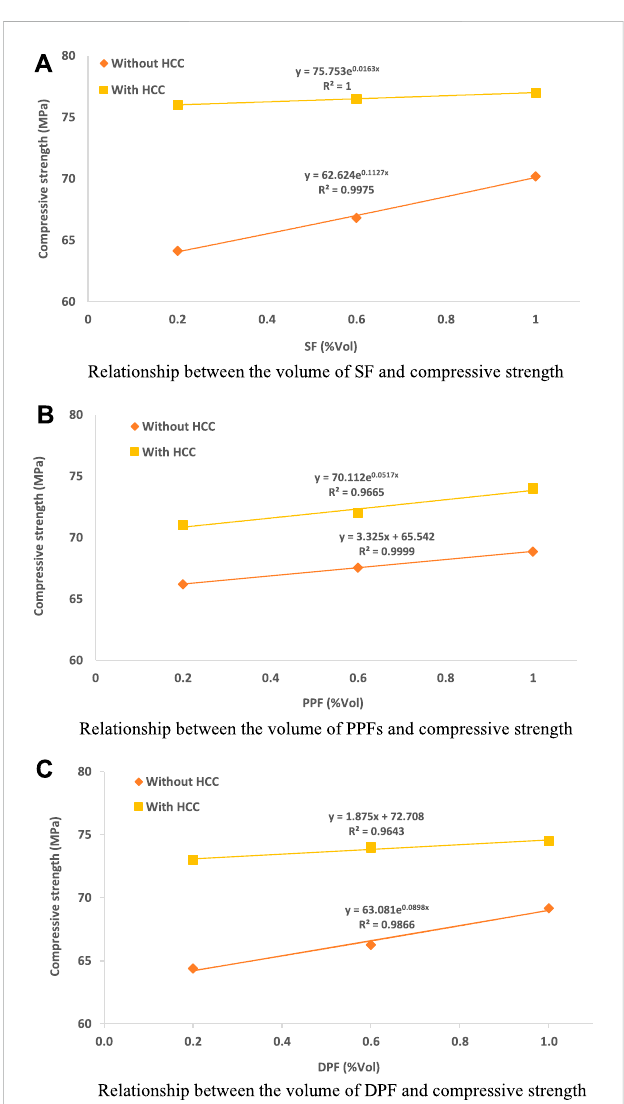
FIGURE 2 Relationship between the volume and compressive strength of SF, PPF, and DPF. (A) Relationship between the volume and compressive strength of SF. (B) Relationship between the volume and compressive strength of PPF. (C) Relationship between the volume and compressive strength of